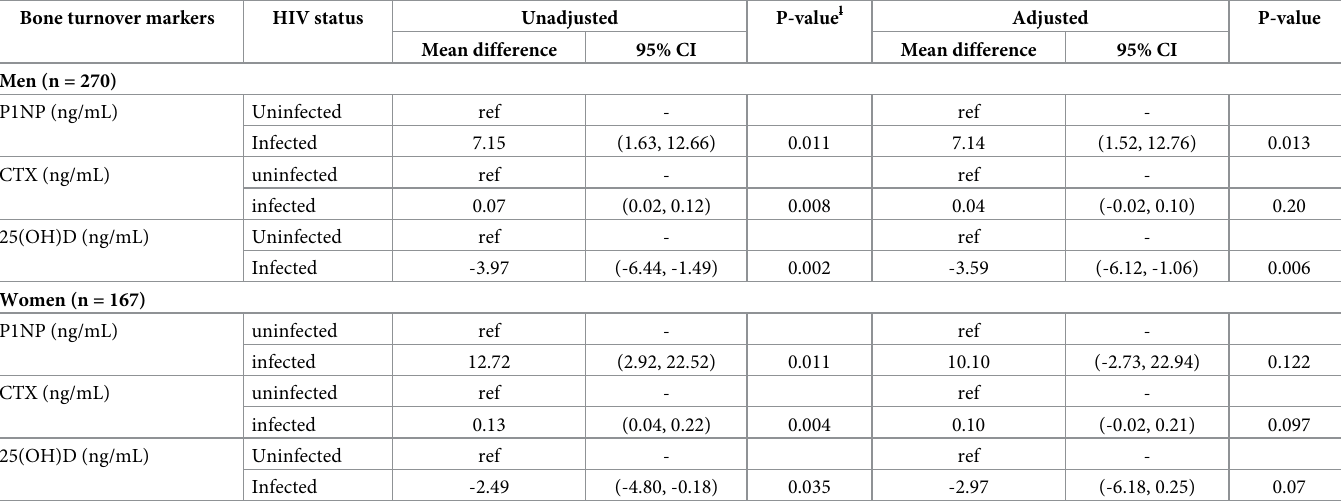
Table 6. Comparison of unadjusted and adjusted bone turnover markers between people living with and without HIV of both sexes. Bone turnover